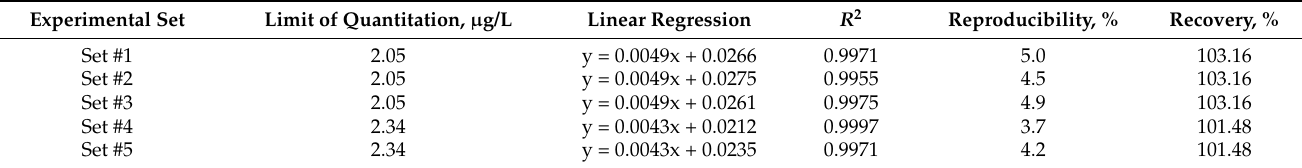
Table 3. Temperature program (temperature and duration in seconds of the stage) for atomic ab- sorption analysis including drying, charring, atomization, and cleaning.